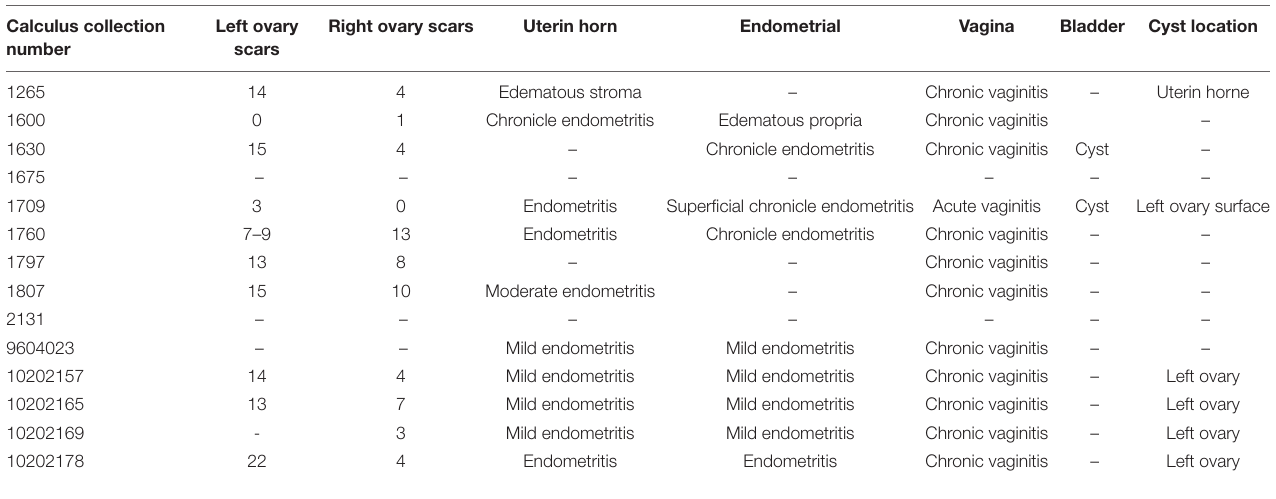
TABLE 2 | Morphometric measurements (mm) and microscopic observations ( n =